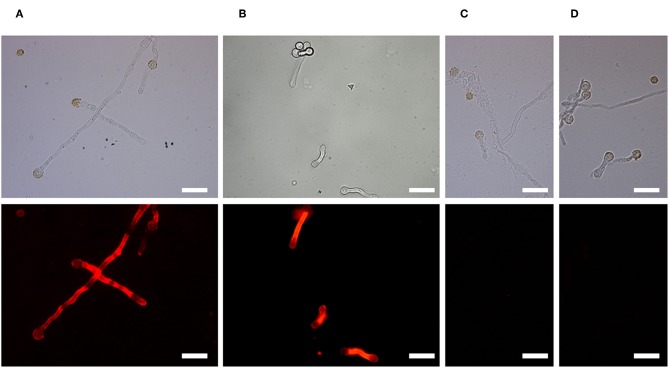
Binding of mAb AP3 to A. parasiticus and A. flavus revealed by immunofluorescence microscopy. (A)
A. parasiticus. (B)
A. flavus. (C)
A. parasiticus control. (D)
A. flavus control. Mycelia were immobilized on glass coverslips and incubated with 200 μl hybridoma supernatant containing 25 μg/ml mAb AP3 or (Rasche et al., 2011; unrelated control). The binding of AP3 to its antigen was verified using GAMDylight 594 H + L (1.5 μg/ml). Antibody–antigen complexes were visualized under a Leica DMR fluorescence microscope. For comparison, light microscope images are shown above the immunofluorescence images. Scale bar = 50 μm.